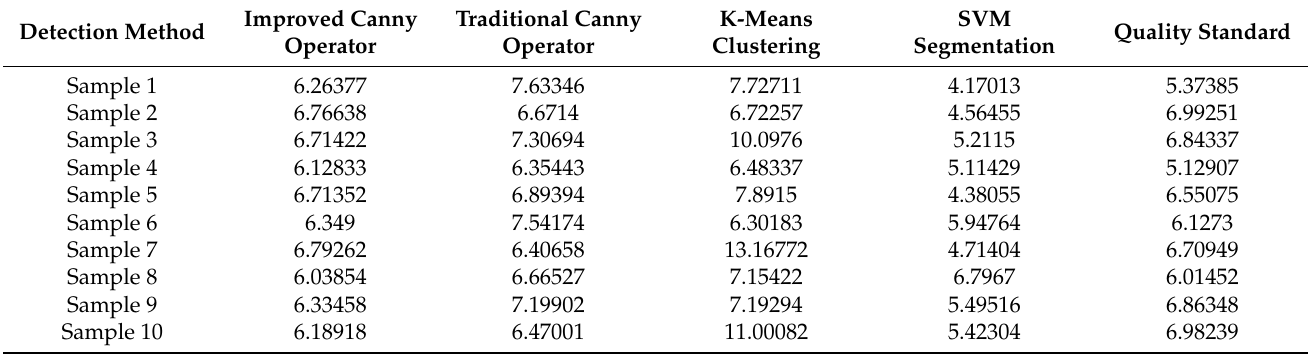
Table 5. Detection results of impurity rate of different algorithms